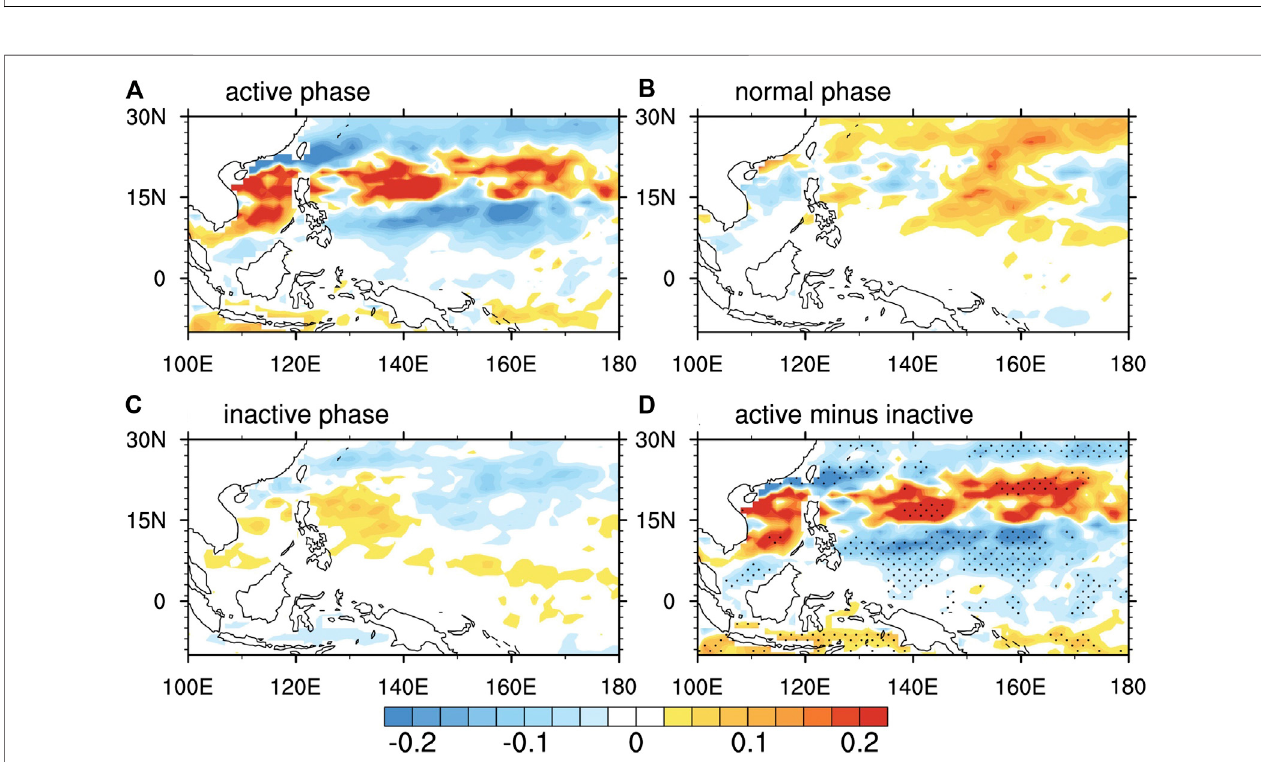
FIGURE 9 | Same as in Figure 7 , but showing the δ GPI (GPI anomaly) fi elds.